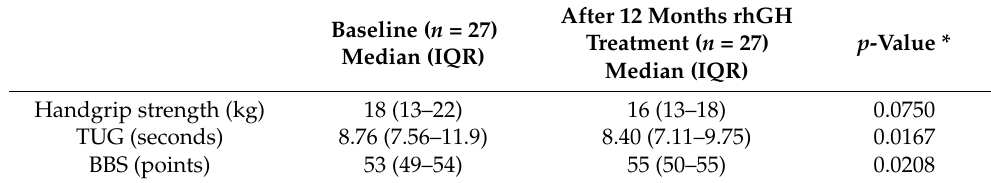
Table 3. Motor function at baseline and 12 months after the initiation of rhGH therapy in subjects with